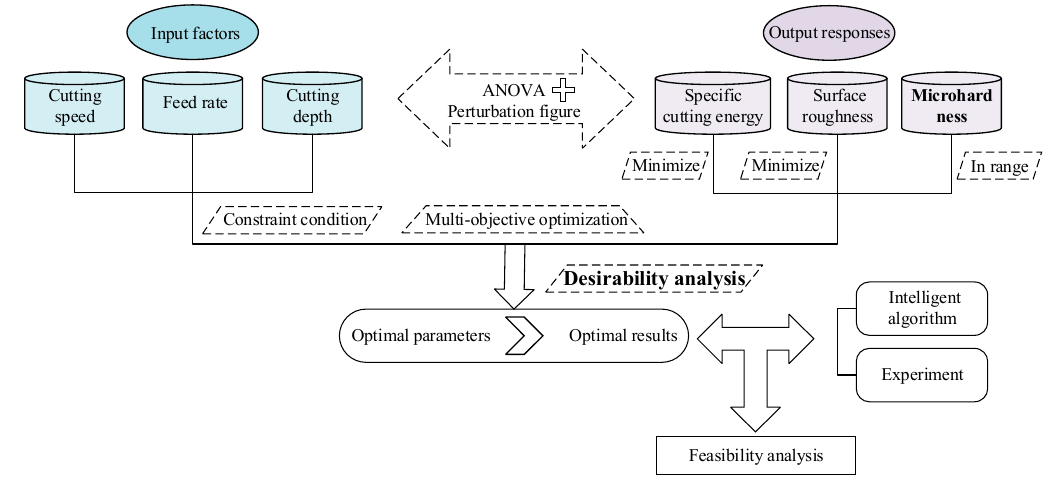
Figure 1. Flow chart of the study.